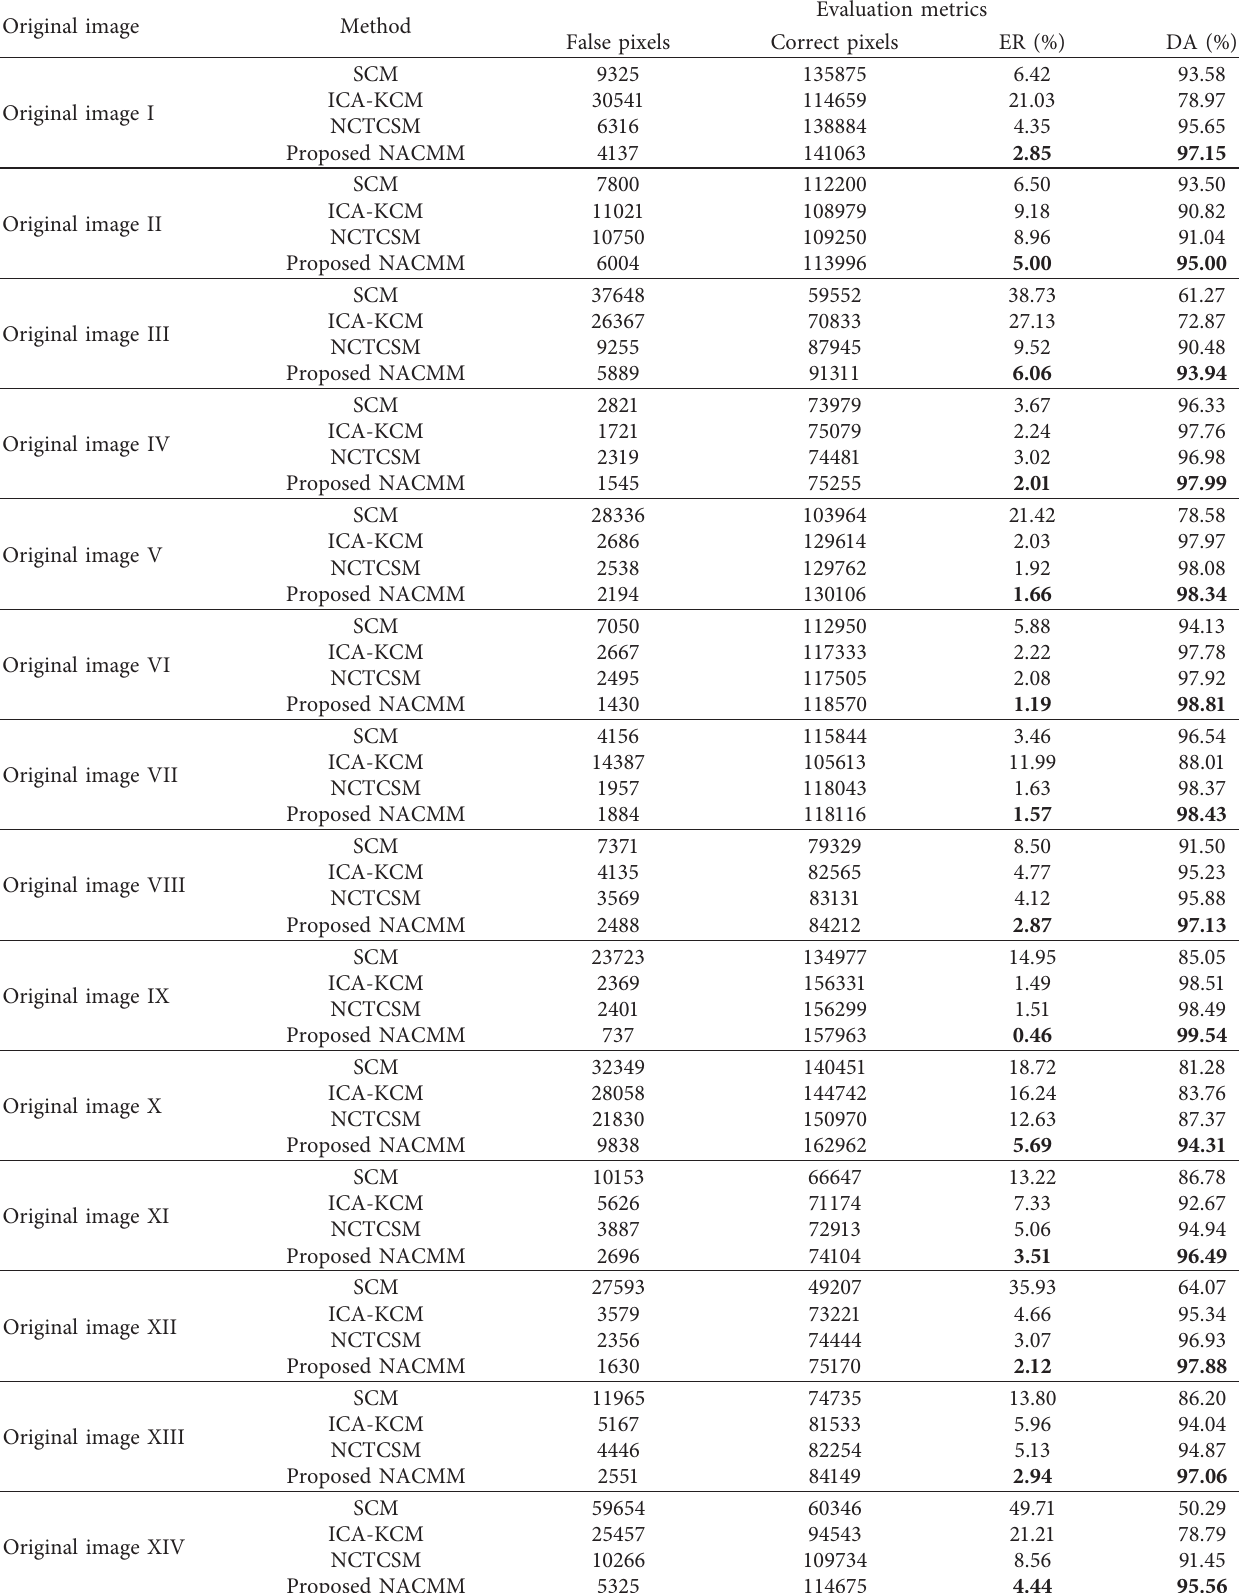
Table 3: The comparison metrics of flame segmentation of original images